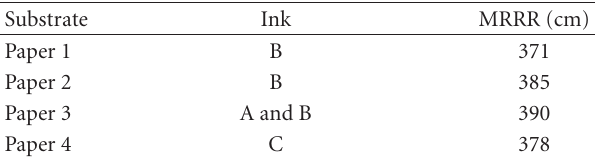
Table 9: The best MRRR values behind five paper reams measured with linearly polarized reader antenna.